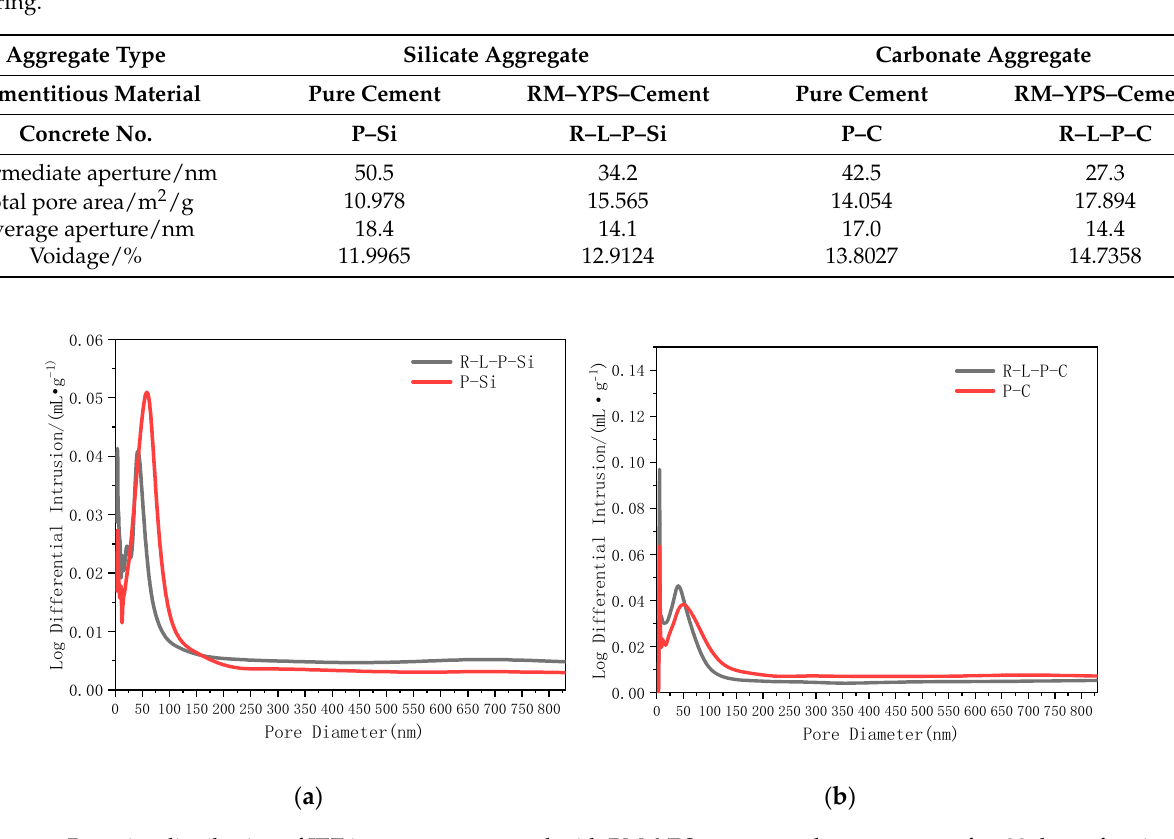
Figure 7. Pore size distribution of ITZ in concrete prepared with RM–YPS–cement and pure cement after 28 days of curing (( a ): Pore size distribution of ITZ of R–L–P–Si and P–Si concrete; ( b ): Pore size distribution of ITZ of R–L–P–C and P–C concrete).